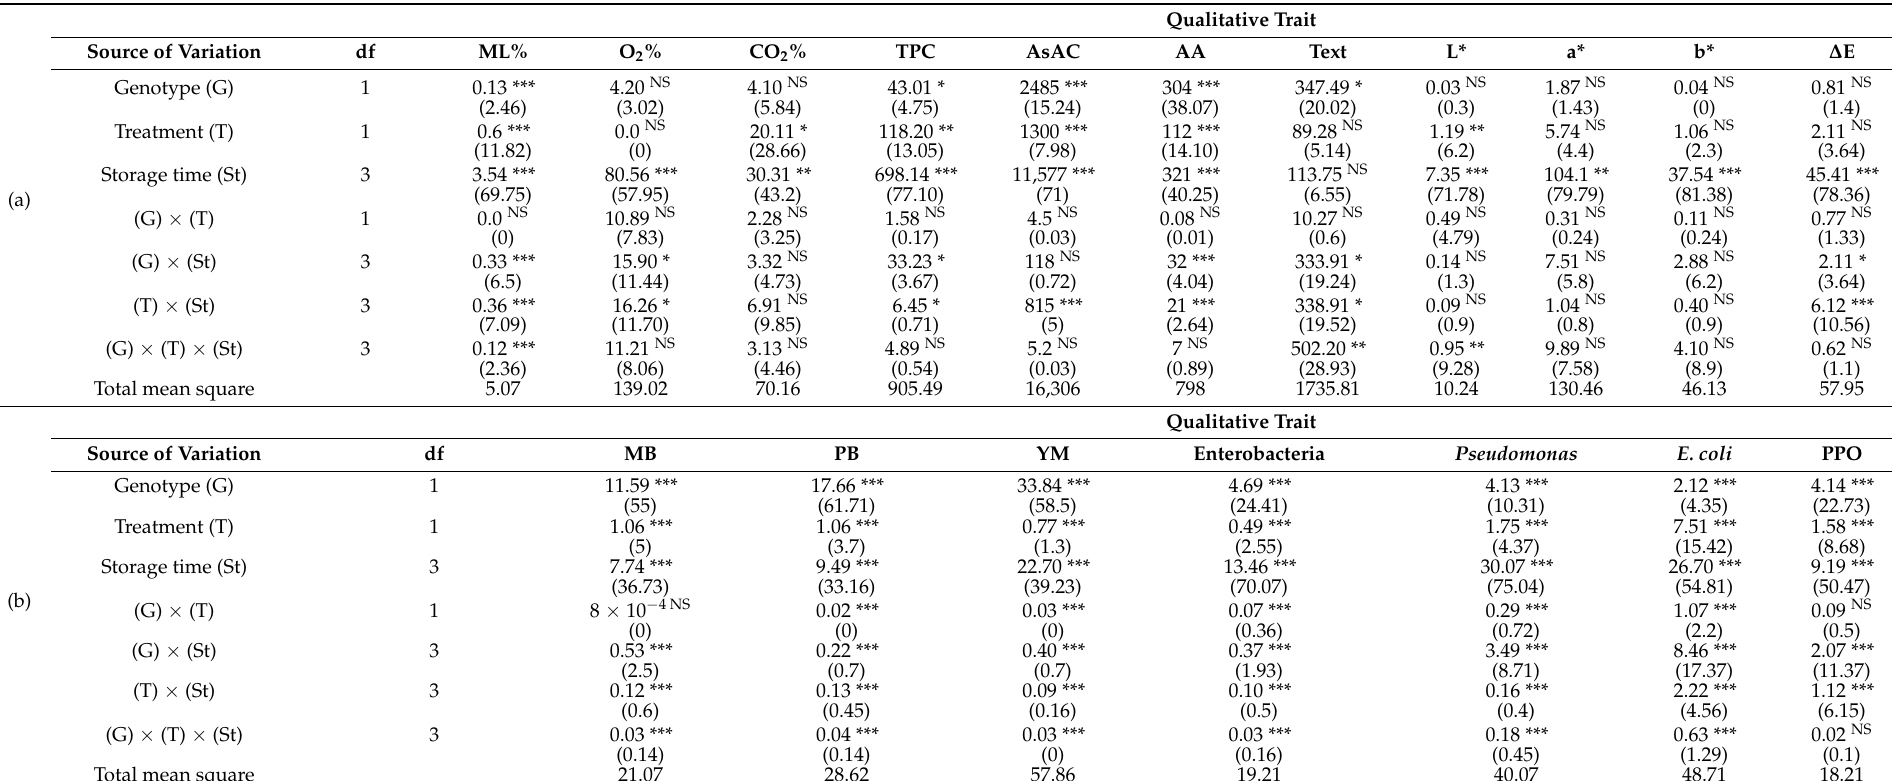
Table 1. Mean square as absolute value and percentage of total (in brackets) of effects resulting from analysis of